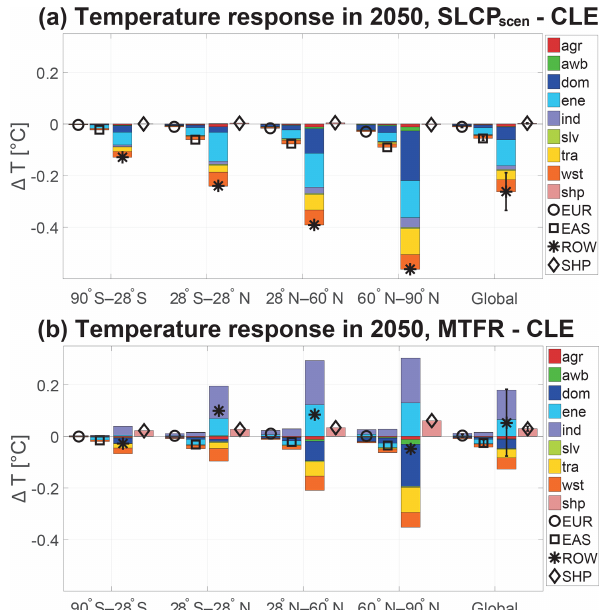
Figure 4. The temperature response in the latitude bands and glob- ally in 2050 for emission sectors and species for the (a) SLCP scen and (b) MTFR scenarios relative to the baseline CLE. Future global temperature change will also be impacted by historic and base- line emissions, which are not accounted for here. The emission sectors are agriculture (agr), agriculture waste burning (awb), do- mestic (dom), energy (ene), industry (ind), solvent (slv), transporta- tion (tra), waste (wst), and shipping (shp). The net response in the latitude bands due to emissions from each emission sector is given by the symbols. Error bars representing 1SD are given for the sec- tors for the global temperature response. They are calculated based on literature values for Gaussian uncertainties in per-component RF, assuming no interspecies correlation, and estimated using a Monte Carlo analysis (100000 pulls), where component forcing values are drawn from within the uncertainty